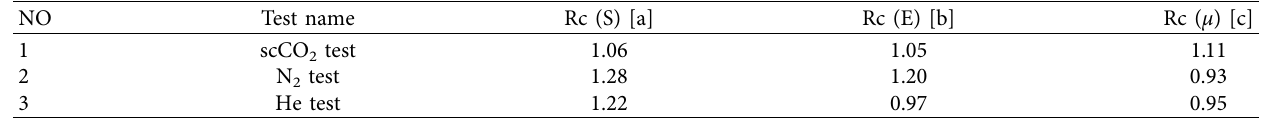
Figure 15: Te relationship between the coring angle and the Poisson’s ratio. Table 3: Te mechanical anisotropy of the three tests.